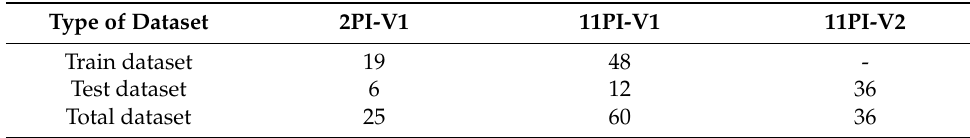
Table 5. Details of the datasets.